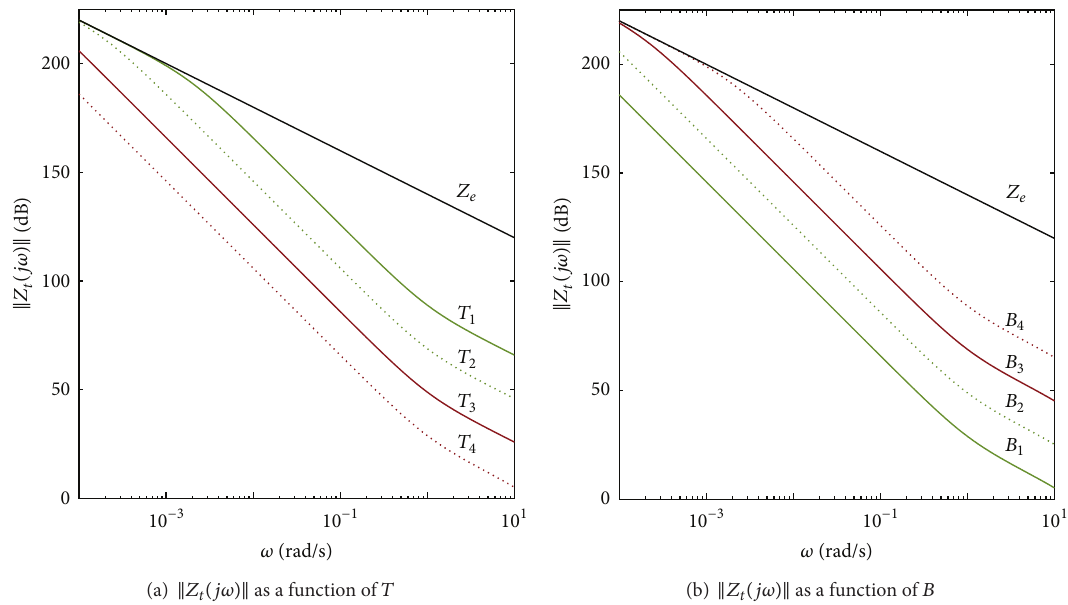
Figure 4: Bode magnitude plot of transmitted impedance 𝑍 𝑡 (𝑠) for the constrained motion case, 𝑍 𝑒 (𝑠) = 𝑘 𝑒 /(Λ + 𝑠) . (a) ‖𝑍 𝑡 (𝑗𝜔)‖ plotted for different delays when 𝐵 = 1[ N ⋅ m / s ] is fixed. (b) ‖𝑍 𝑡 (𝑗𝜔)‖ plotted for different wave impedances when 𝑇 = 0.1 [ s ] is